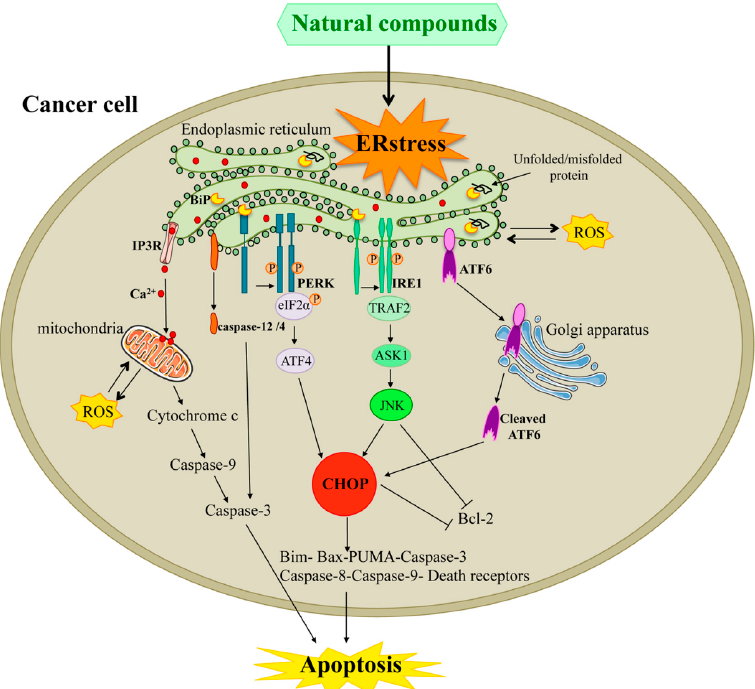
Figure 1. ER stress-related apoptosis triggered by natural compounds. If the adaptive UPR pathway is not able to restore the ER function, upon severe or prolonged ER stress, activation of ER stress